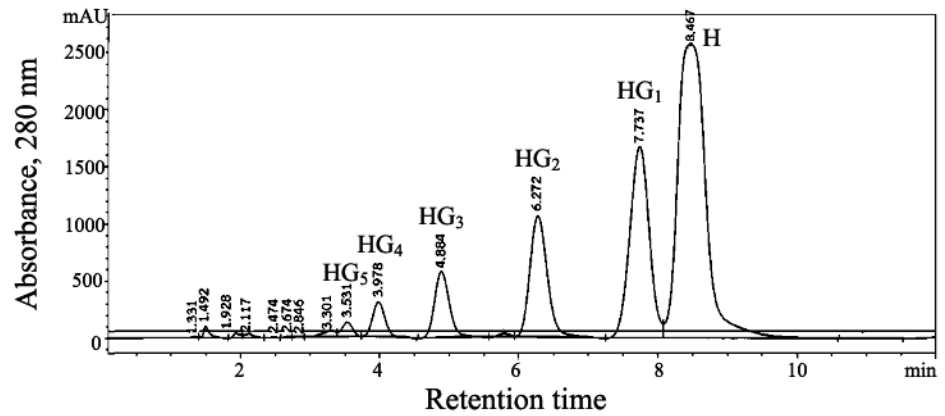
Figure 1. Detection of hesperidin glycoside products using preparative HPLC chromatography profile of transglycosylation catalyzed using recombinant CGTase from p19bBC cells. The transglycosylation volume of synthesis was scaled up to 300 mL. The reaction mixture was filtered through a 0.45 µm nylon membrane before injecting into preparative HPLC and eluted with acetonitrile:water (20:80 v / v ), using a flow rate of 20 mL/min. Hesperidin (H), hesperidin glucoside (HG 1 ), hesperidin maltoside (HG 2 ), hesperidin maltotrioside (HG 3 ), hesperidin maltotetraoside (HG 4 ), and hesperidin maltopentaoside (HG 5 ).